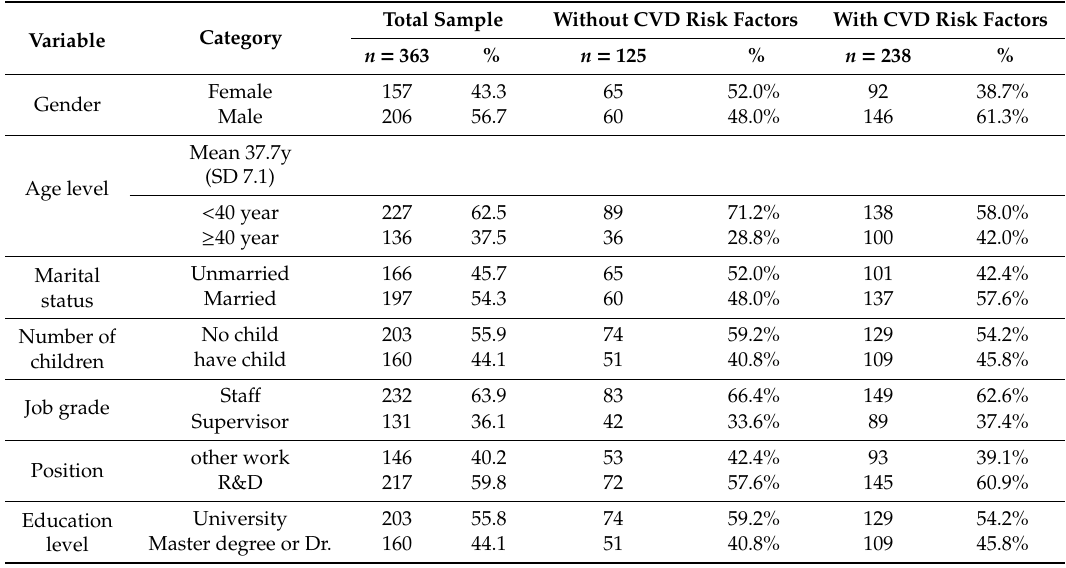
Table 1. Demographic characteristics of high-tech company employees.